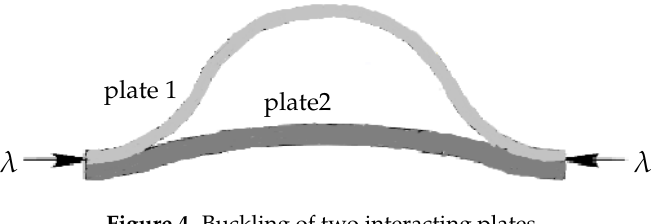
Figure 4. Buckling of two interacting plates.